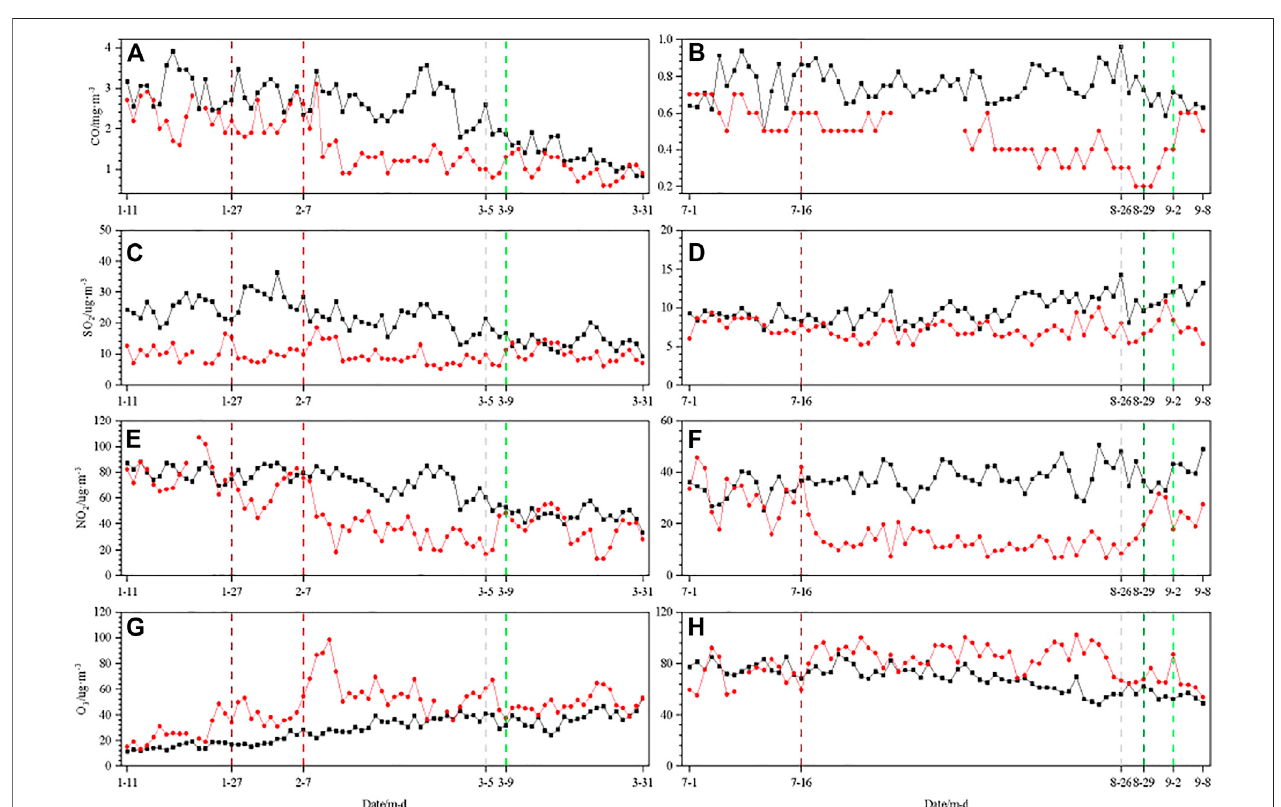
FIGURE 1 | Daily average CO, SO 2 , NO 2 , and O 3 concentrations during the (A – D) winter and (E – H) summer lockdowns in Urumqi. The black dots represent the 2015 – 2019 historical data and the red dots represent the 2020 data. The dark red vertical line indicates the beginning of the winter lockdown. The red vertical lines indicate the beginning of strict lockdown measures, and the gray vertical lines indicate the initial lifting of lockdown measures. The dark green line indicates the lifting of vehicle restrictions during the summer lockdown, and the green lines indicate the complete lifting of lockdown measures.